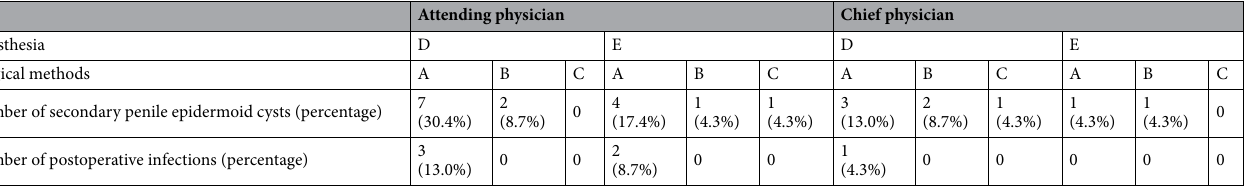
Table 9. Surgeons and the occurrence of secondary epidermoid cysts of the penis. A: Manual circumcision, B: Ligature circumcision, C: Stapler circumcision, D: Penis root injection anesthesia, E: Lidocaine ointment anesthesia. Statistics show that the incidence of secondary penile epidermoid cysts in the chief physician is lower than that in the attending physician, especially after manual circumcision. The incidence of infection after manual circumcision in the attending physician was higher than that in the chief